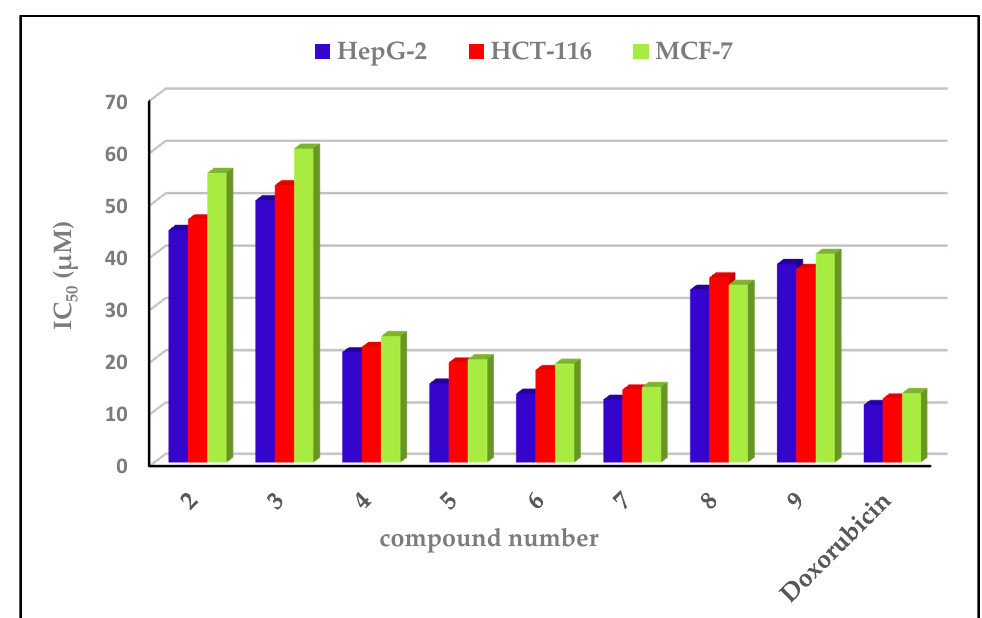
Figure 4. In vitro anticancer effects of the target compounds on the HepG-2, HCT-116, and MCF-7 cell lines.